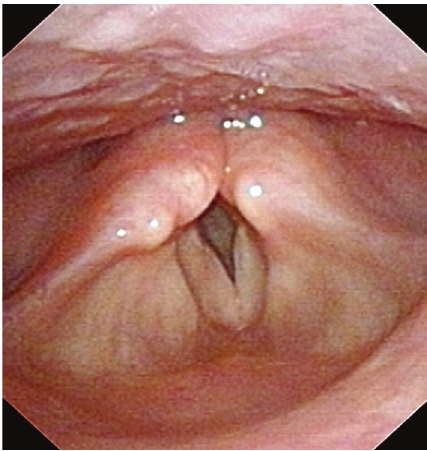
Figure 1: Nasofibroscopic view of the larynx in maximum abduc- tion showing left vocal cord immobility in